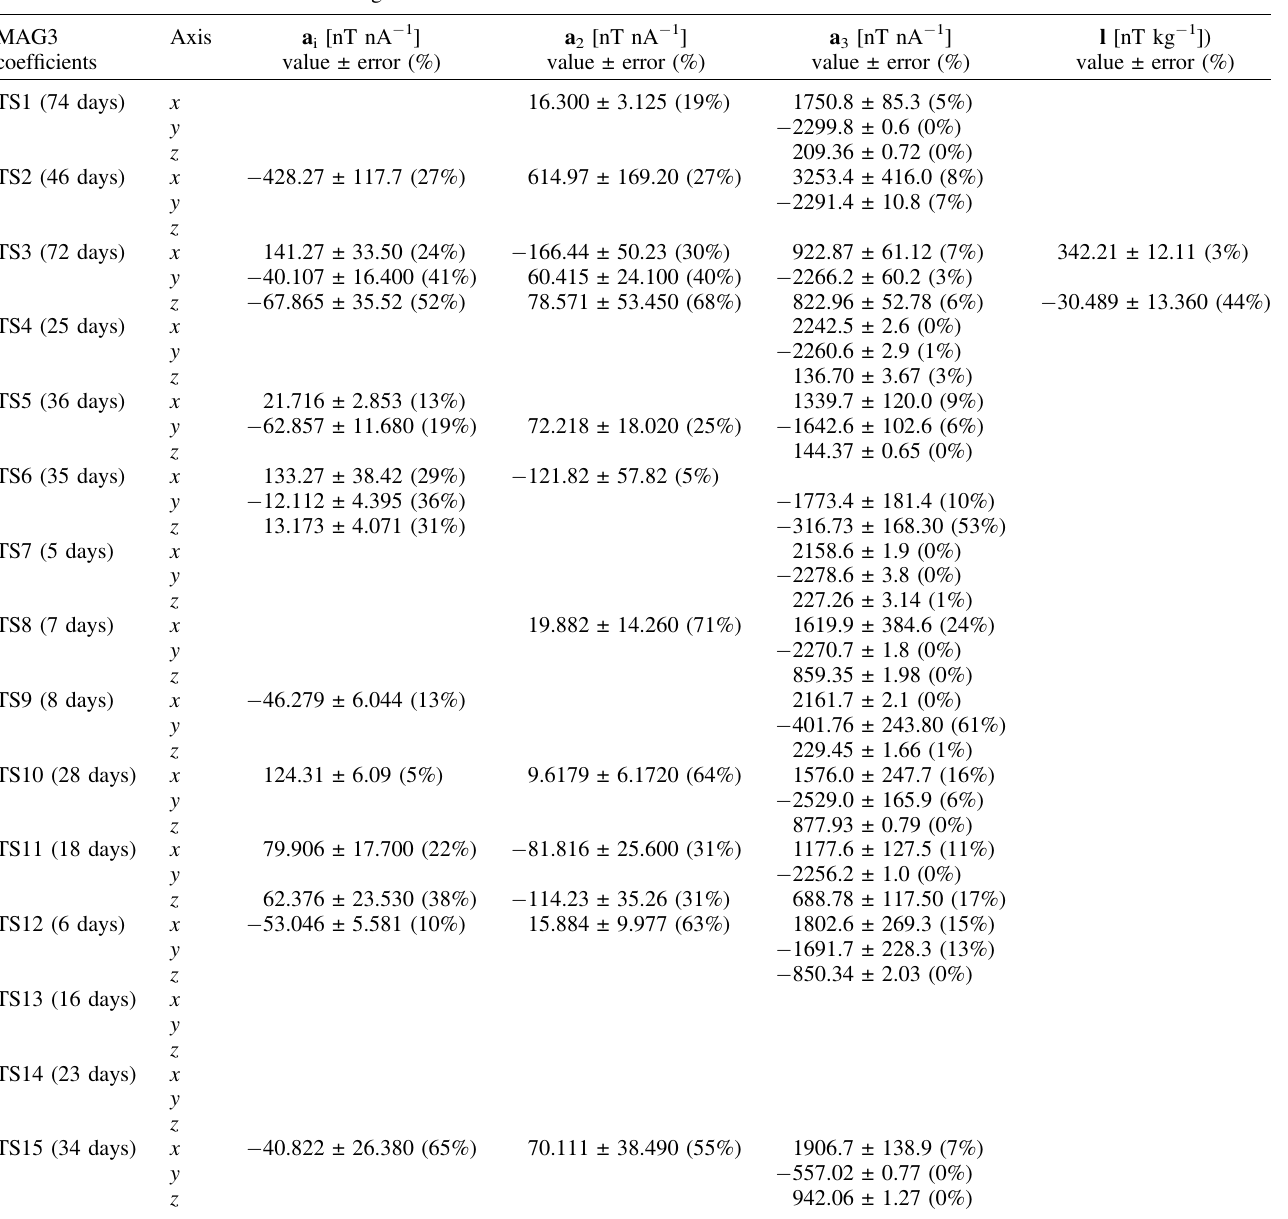
Table 5. Same as Table 3 for the PX magnetometer. MAG3 coef fi